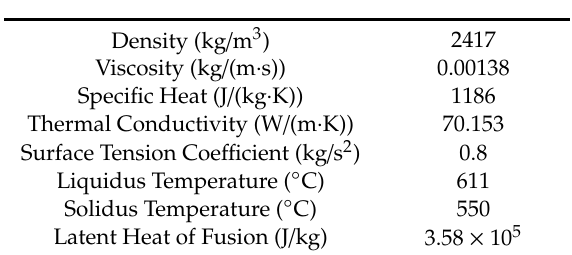
Table 2. Material